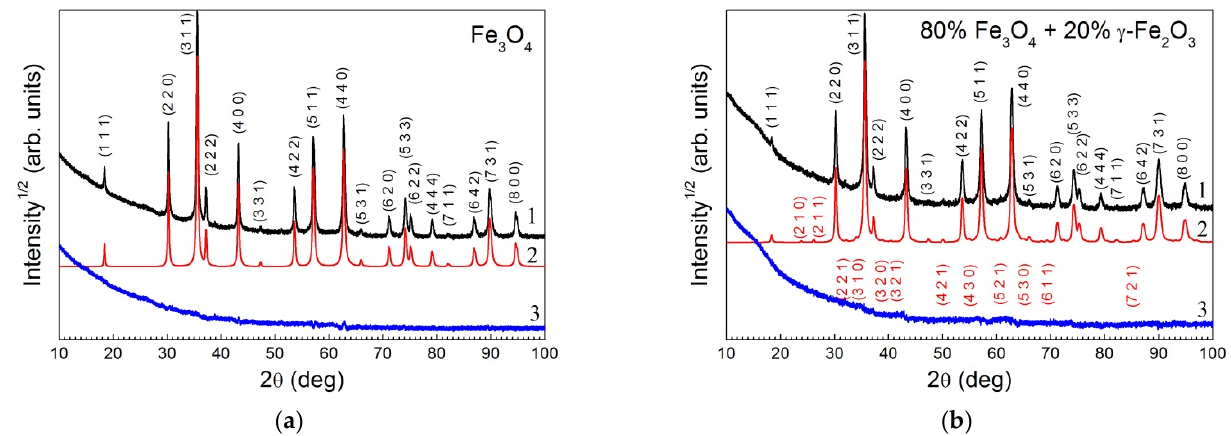
Figure 2. Observed (1), calculated (2), and different (3) XRD profiles after DDM refinement for the initial Fe 3 O 4 @C sample ( a ) and for the double carbon coated Fe 3 O 4 @C@C sample ( b ). The crystal planes corresponding to the observed reflections are marked in black for magnetite ( a ) and red for maghemite ( b ). Most of the reflexes coincide for both compounds ( a , b ), but some of them of very low intensity are characteristic only of maghemite ( b ).